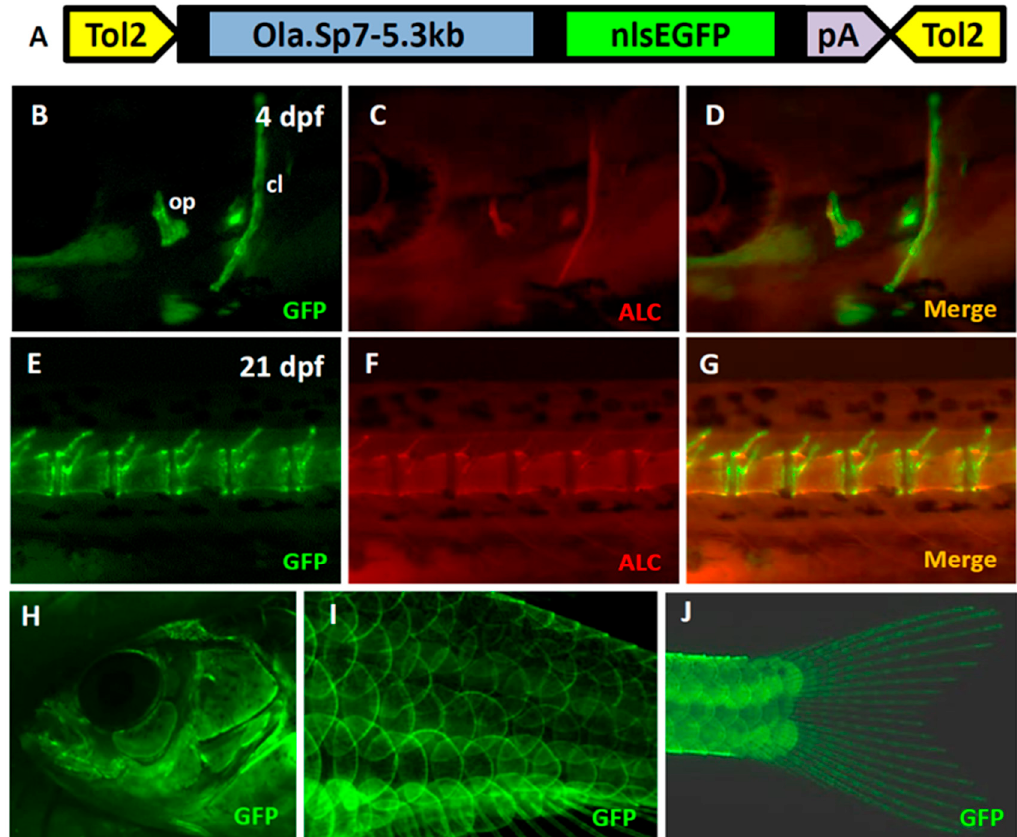
Figure A1. Generation of Tg(Ola.Sp7:EGFP) cy25 as a control fish to show the osteoblast-specific property of sp7 promoter. ( A ) Schematic diagram of vector (pDestTol2CG2-Ola.Sp7-nlsEGFP-pA) which was used to express EGFP reporter gene driven by a 5.3kb Medaka sp7 promoter uniquely in osteoblasts. Green fluorescence was expressed in opercula and cleithrum ( B ), notochord ( E ), fish head ( H ), body scales ( I ) and caudal fin ( J ). The transgenic fish was also counterstained with alizarin complexone (ALC) for mineralized tissue staining (red fluorescent color). The ALC stained opercula and cleithrum as well as notochord were shown in (C) and (F), respectively. The merged images for EGFP (green) and ALC (red) in opercula and cleithrum and notochord were highlighted in ( D ) and ( G ), respectively.